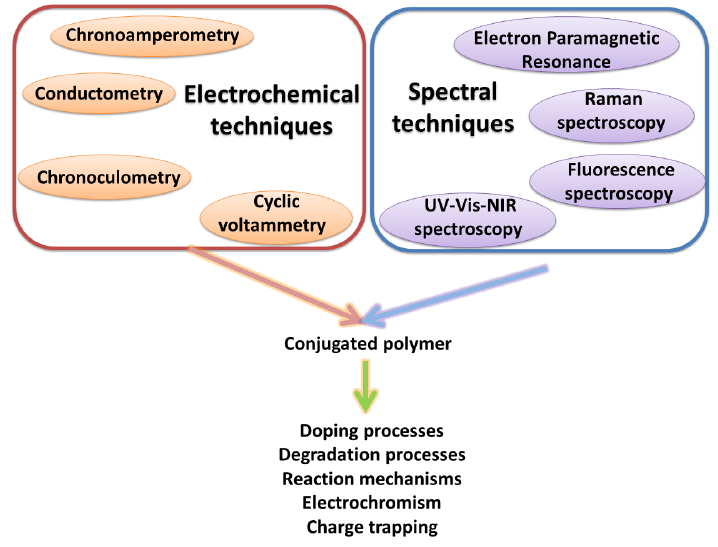
Figure 7. Graphical presentation of different combinations of electrochemical and spectral methods used in spectroelectrochemistry.